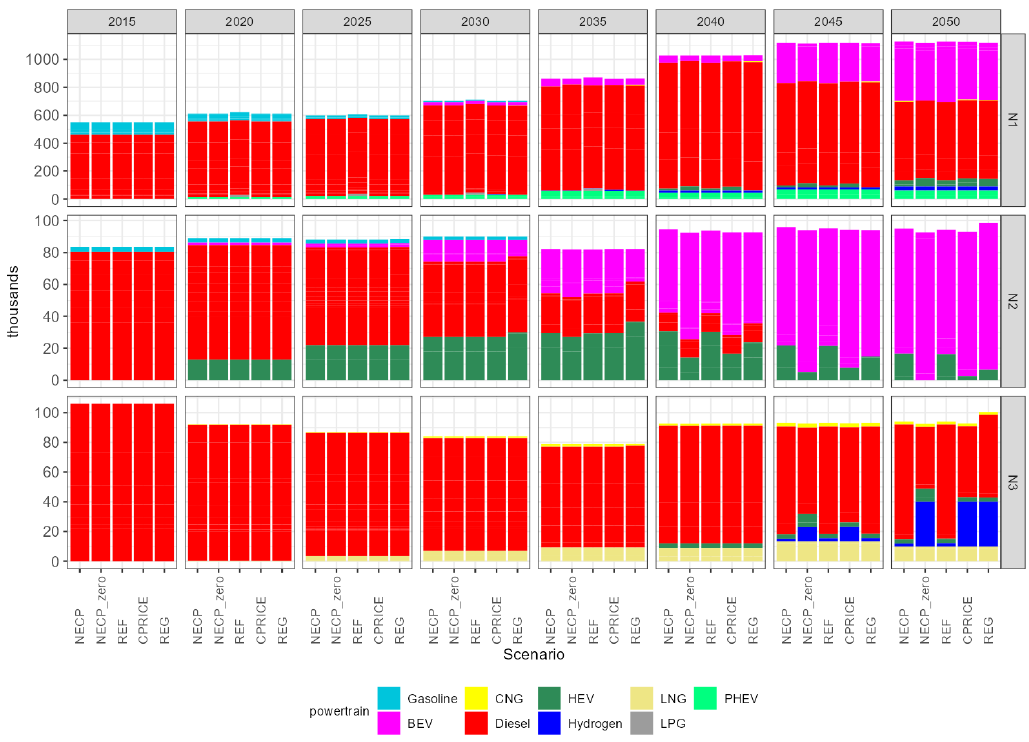
Figure 15. Structure of freight road vehicle fleet by categories and powertrain.